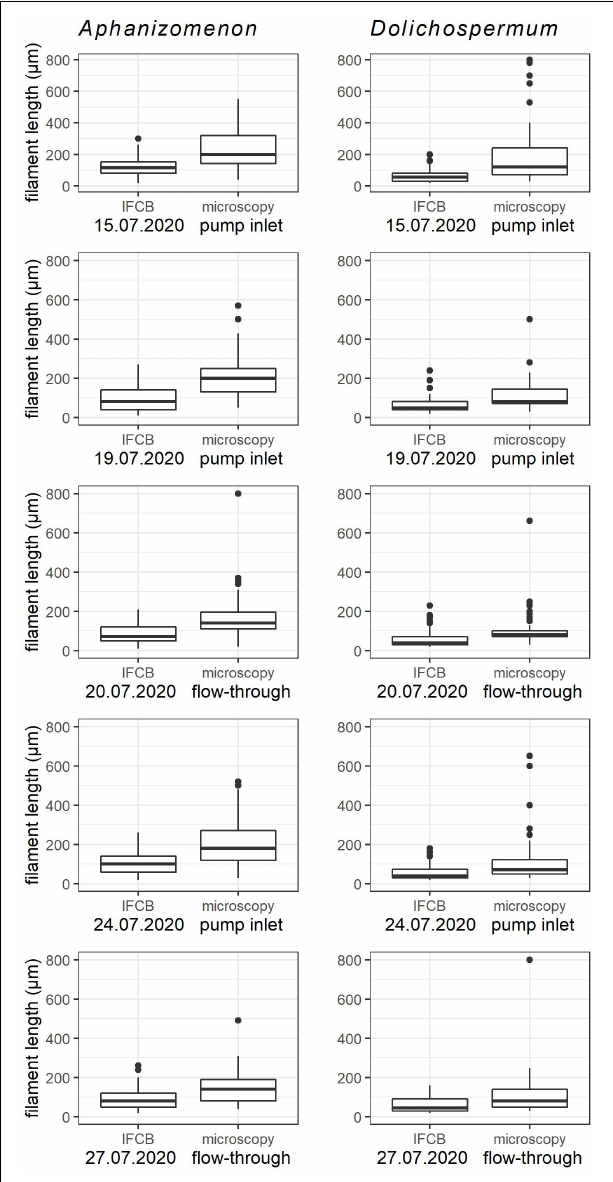
FIGURE 5 | The lengths of the measured filaments from IFCB and microscopy samples. Left hand panels Aphanizomenon , right hand panels Dolichospermum. The “pump inlet” and “flow-through” indicates the sampling point of the microscopy